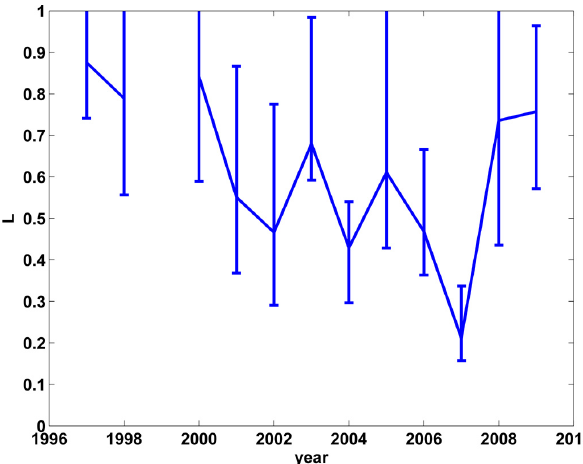
Fig. 2. Variations of effective losses in the antenna feed together with their quartiles for